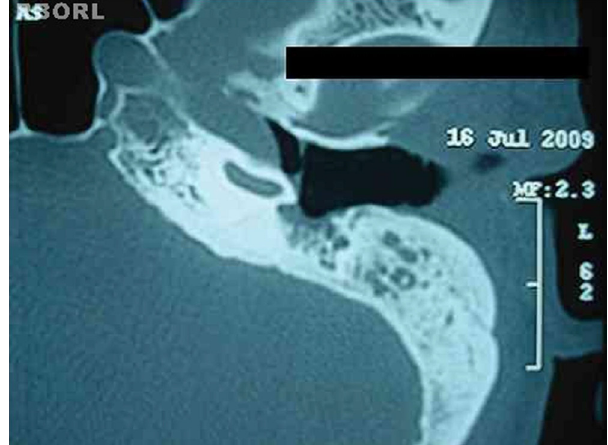
Figure 1 Left ear axial computed tomography scan --- petrous internal carotid artery filling protympanum and veiled posterior